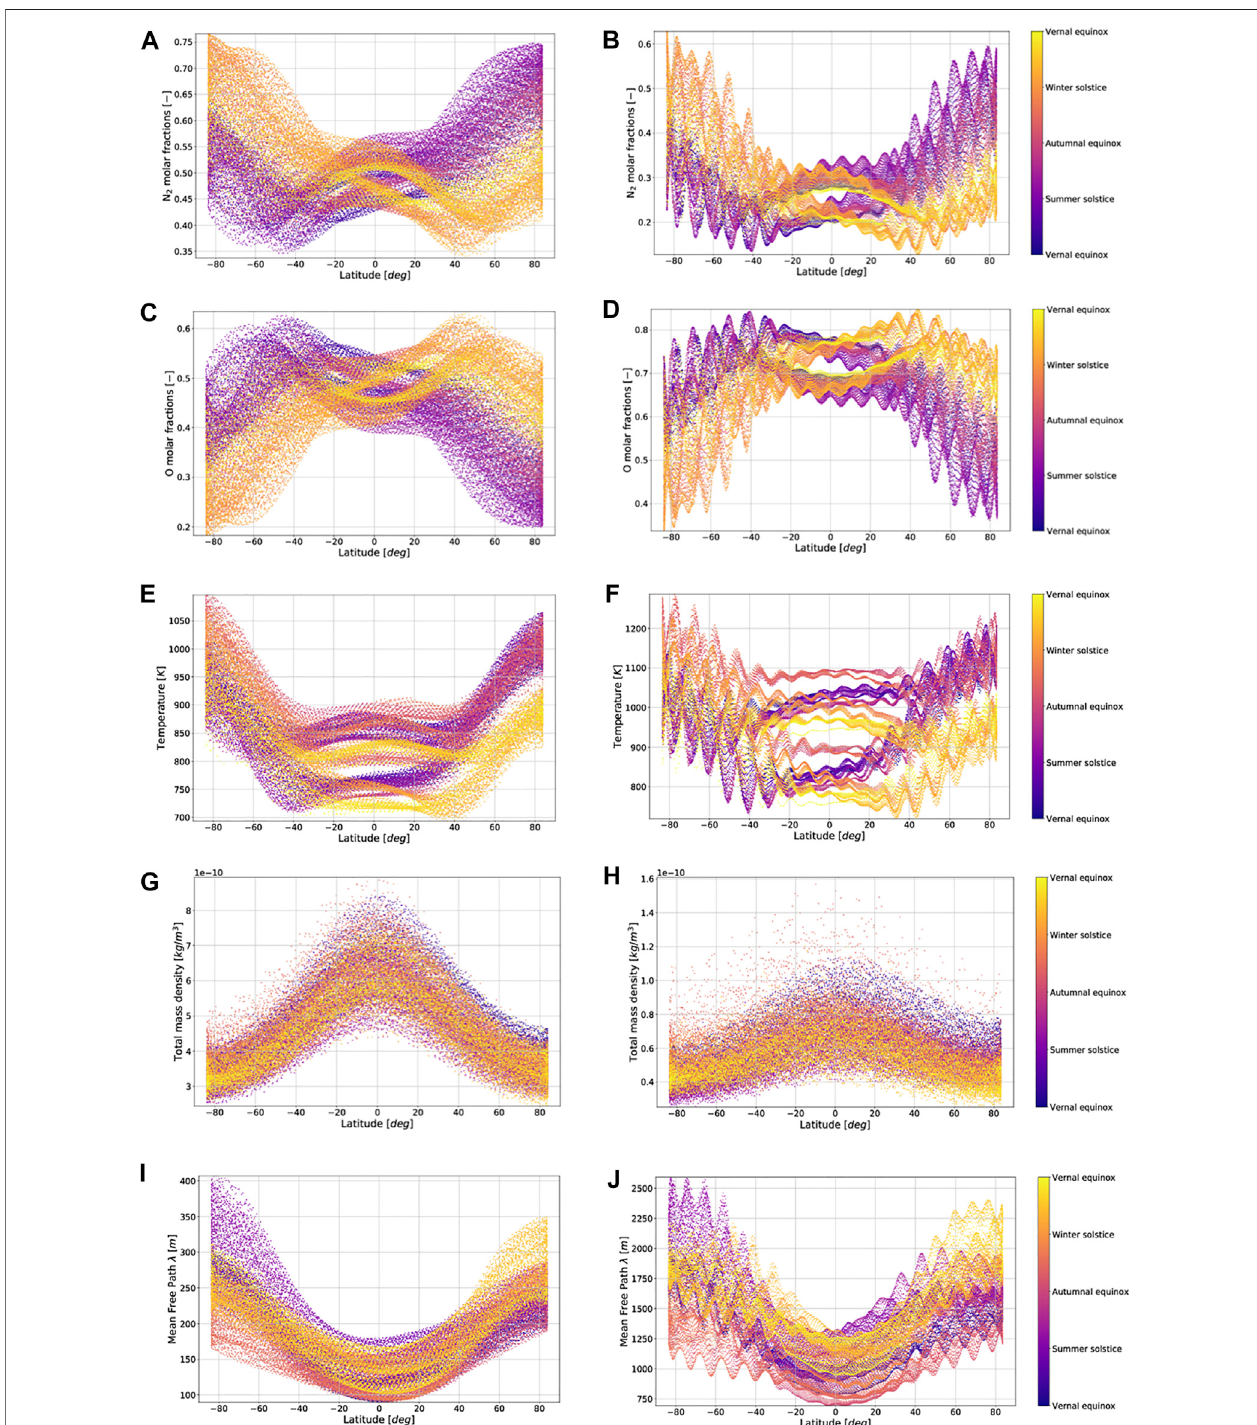
FIGURE3| YearlyN 2 molarfractionvariationfora180 km (A) and250 km (B) SSOdawn-duskorbit;yearlyOmolarfractionvariationfora180 km (C) and250 km (D) SSO dawn-dusk orbit; yearly atmospheric temperature variation for a 180 km (E) and 250 km (F) SSO dawn – dusk orbit; yearly atmospheric mass density variation for a 180 km (G) and 250 km (H) SSO dawn-dusk orbit; yearly collision mean free path variation for a 180 km (I) and 250 km (J) SSO dawn-dusk orbit. Period: March 2003 to March 2004.